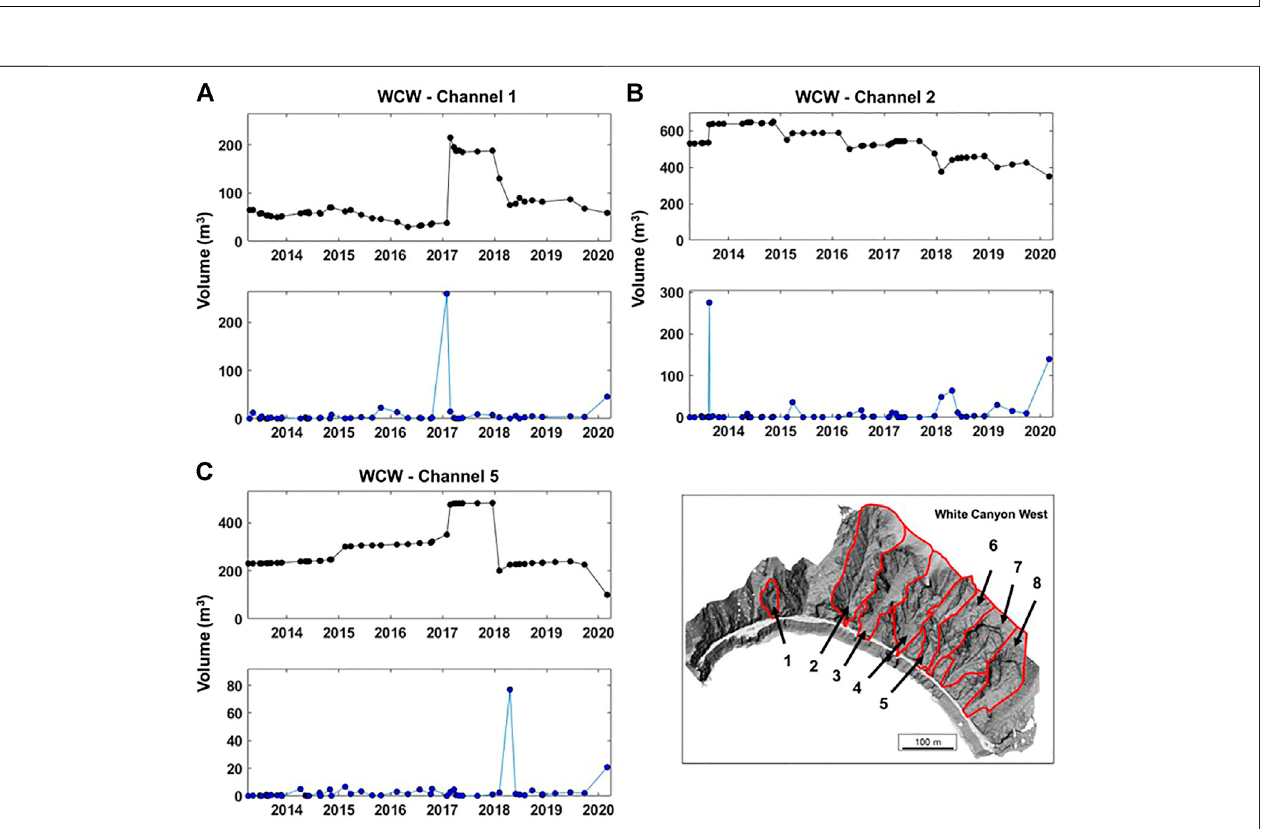
Frontiers in Earth Science |